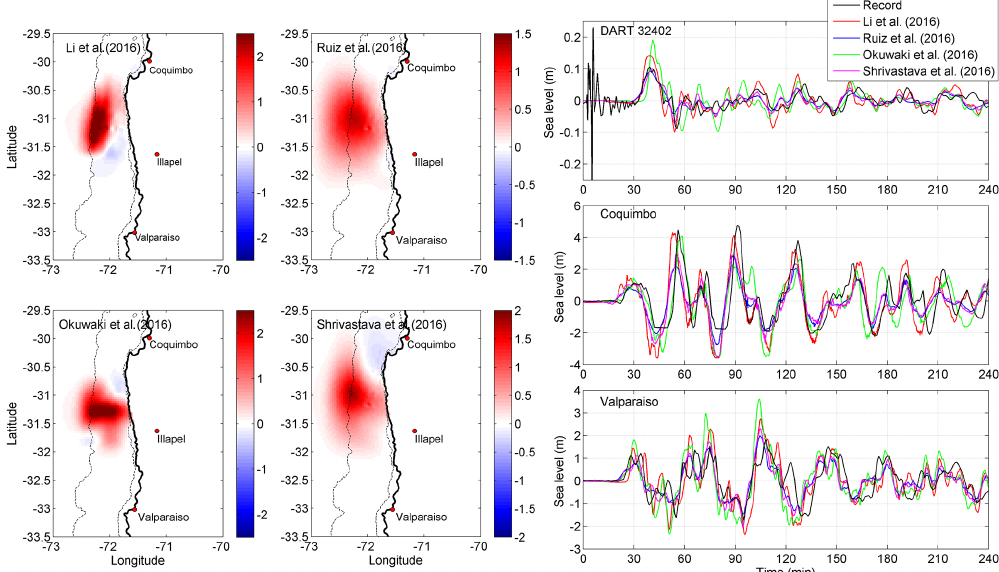
Figure 5. Tsunami initial conditions of four source models and comparison of tsunami records with simulated tsunami waveforms at DART 32402, Coquimbo and Valparaiso.